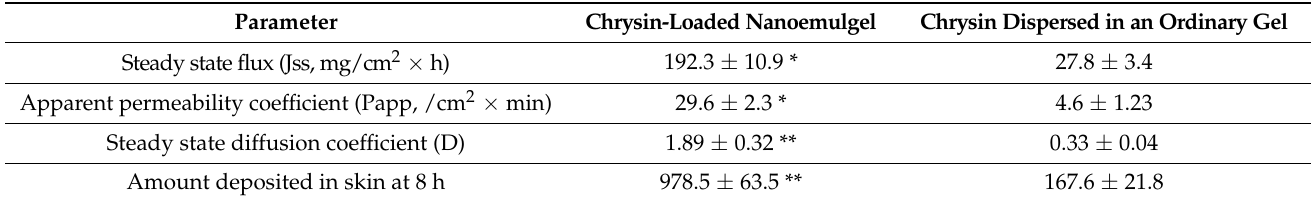
Table 1. Various derived parameters for the percutaneous penetration of chrysin from nanoemulgel and simple